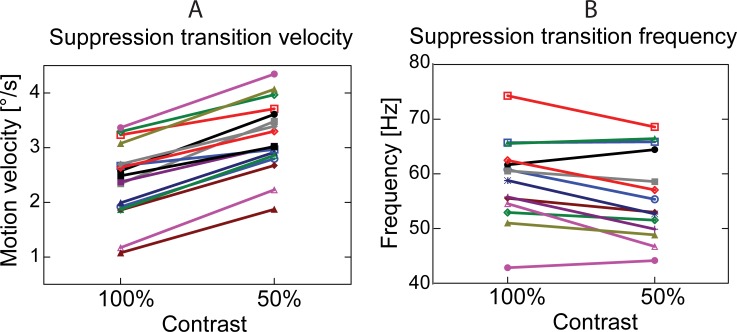
Effect of contrast on the gamma suppression transition point: individual variability.A. The centre of gravity of visual motion velocity that approximates the GR suppression transition point (‘suppression transition velocity’—STVel). The STVel increased with decreasing contrast in all subjects (p<1e-6). B. The centre of gravity that approximates the peak frequency of the GR at the suppression transition point (‘suppression transition frequency’—STFreq) in 14 subjects for whom frequency could be assessed in all experimental conditions (see Materials and Methods for details). The STFreq slightly, but significantly, decreased with decreasing the contrast (p = 0.007).